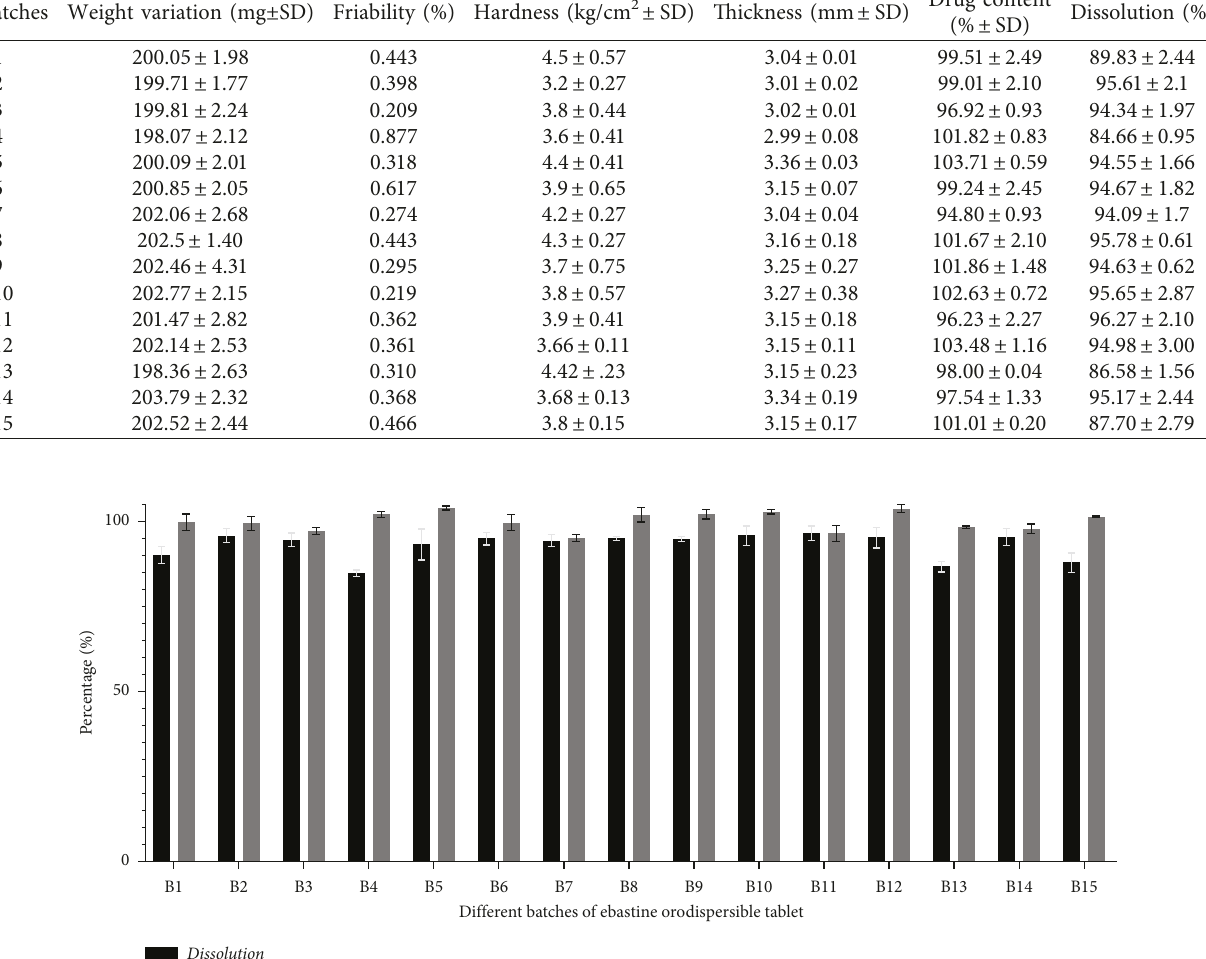
Table 7: Evaluated postcompression parameters of fifteen different trial batches.